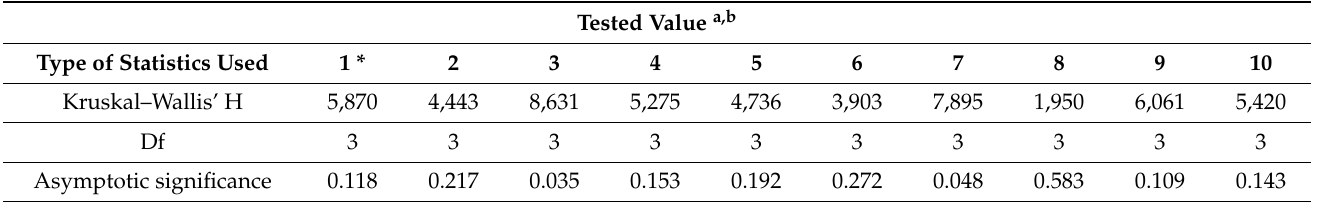
Table 7. Preference for a particular type of onboarding among the respondents with given seniority (tested value a, b). Tested Value